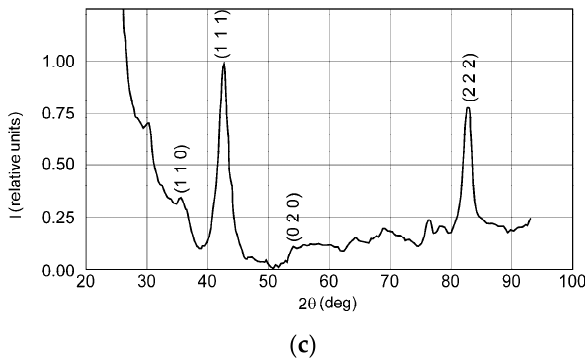
Figure 3. XRD patterns of: ( a ) bulk LaNi 5 powder; ( b ) 4.0 nm thick film; ( c ) 68 nm thick film.